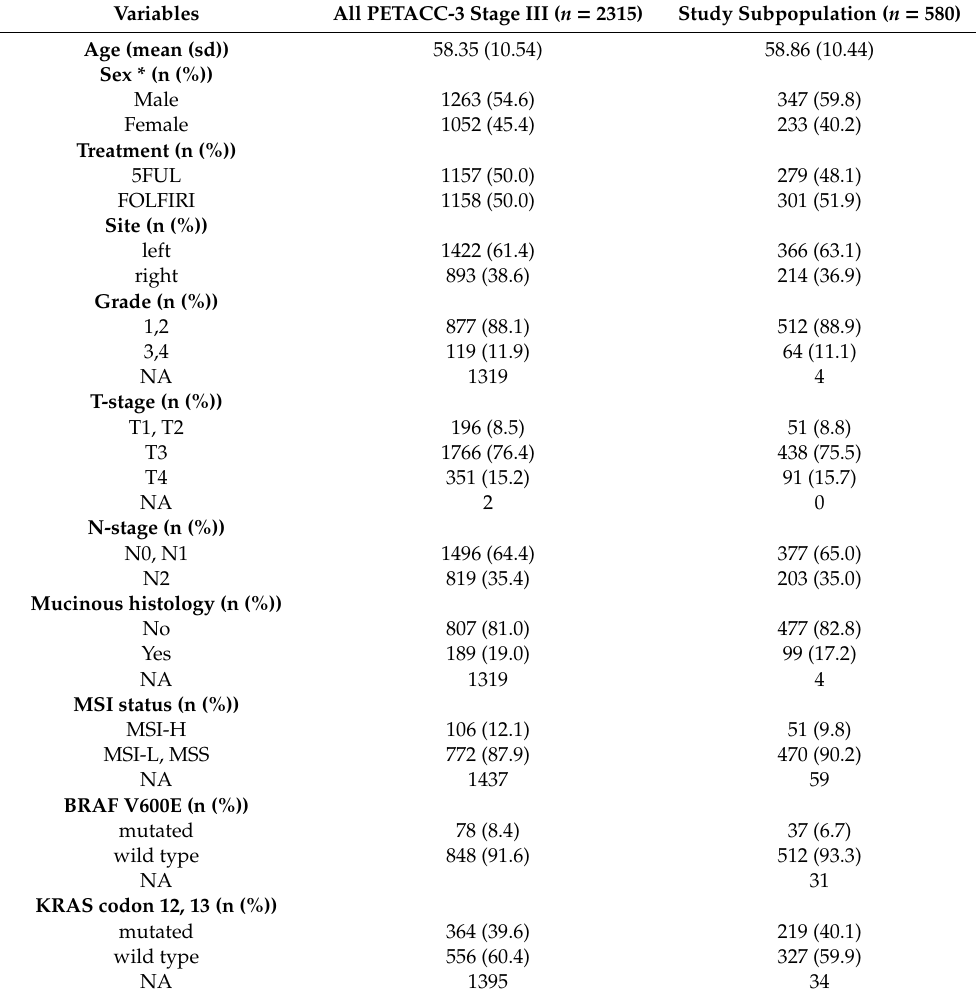
Table 1. Population characteristics for the whole PETACC-3 / Stage III and the study subpopulation. The only statistically significant di ff erence was between male / female proportions (* starred covariate in the table; p = 0.025). The missing values (denoted NA (not available)) were not considered when computing the proportions. Microsatellite Instability (MSI) Status is divided into MSI High (MSI-H), MSI Low (MSI-L) and Microsatellite Stable